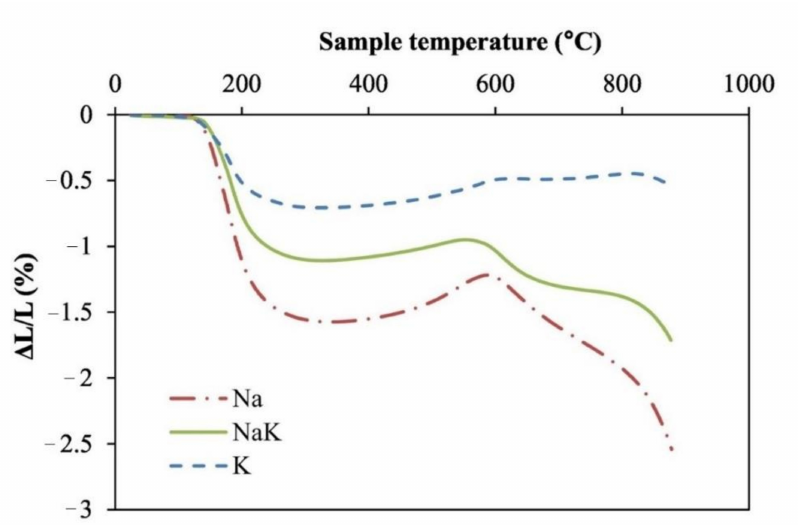
Figure 3. Thermal distortion of the geopolymers by dilatometry process